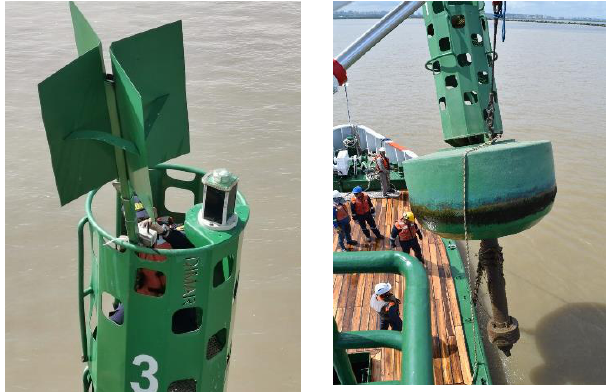
Figure 2. Installation process of the buoys with the sensor systems in the Magdalena River.